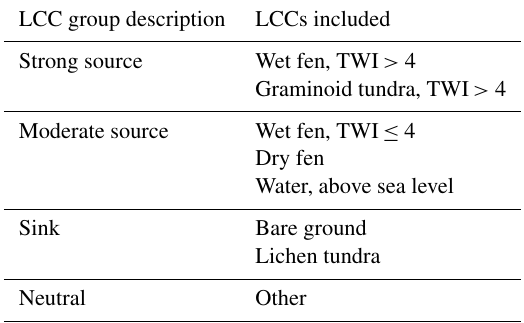
Table 3. Aggregated land cover classes for the regression